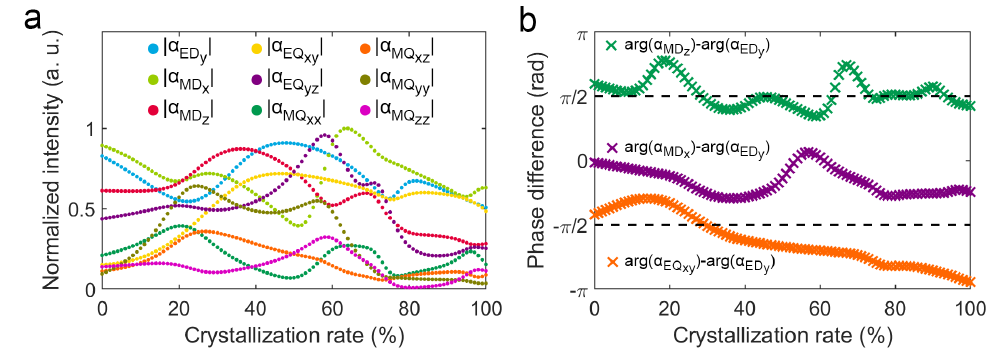
Figure 4. Multipole moments at 3.6 µ m wavelength: ( a ) Normalized moduli of multipole moments as functions of the crystallinity; ( b ) Interference phase differences of multipole moments as functions of the